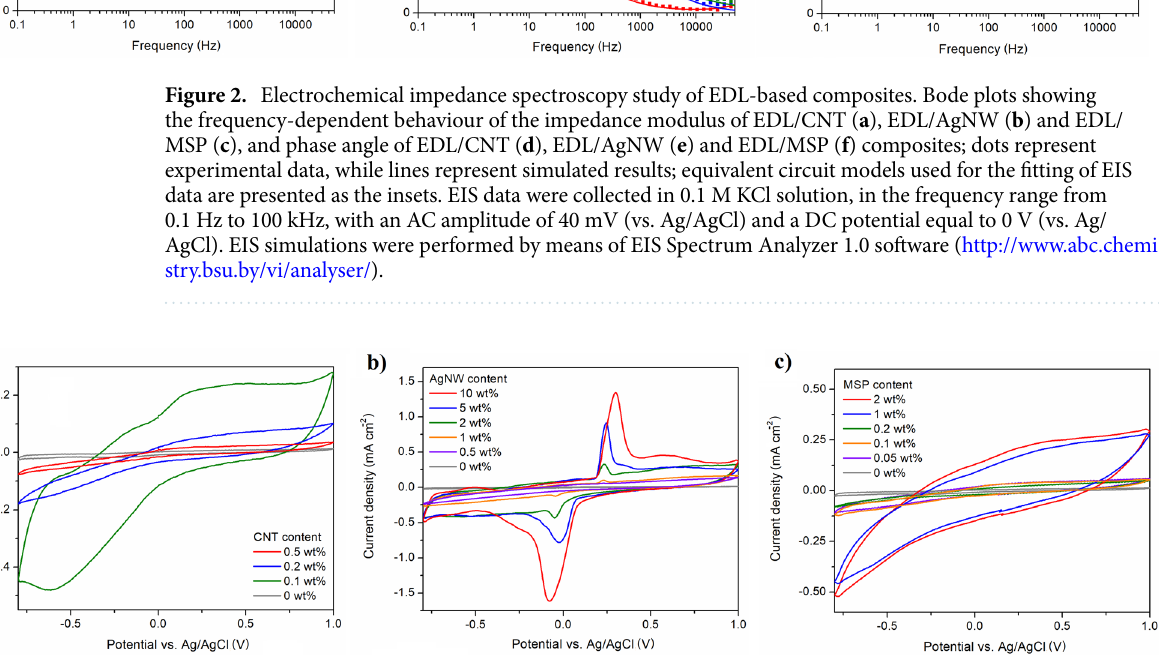
the CV curves of EDL/AgNW nanocomposites (Fig. 3b) were characterized by a distinctive reduction–oxidation system at the potentials of − 0.05 V (reduction of silver) and 0.25 V (oxidation of silver), appearing for composites with AgNW contents above 0.5 wt%. With an increase in AgNW content, an increase in the peak current was observed, accompanied by a small increase in peak separation (from 270 mV for EDL/AgNW 1 wt% to 380 mV for EDL/AgNW 10 wt%). Conversely, an increase in the area under the CV curve with no defined indication of reduction/oxidation peaks was observed for EDL/MSP (Fig. 3c), starting from an MSP content of 1 wt%. By integrating CV curves in the time domain, the charge storage capacities (CSC) of EDL composites were calculated and compared with capacitances and resistances determined from the equivalent circuit modelling of the EIS data (Fig. 4a–c). One of the most common models is a Randles circuit, which is frequently used to simulate electrode–electrolyte interface impedance of coated electrodes 17 . For the purpose of modelling, a modi- fied Randles circuit was used, including a solution resistance (R 1 ), charge transfer resistance (R 2 ), constant phase element modeling the non-faradaic processes (CPE 1 ), Warburg element representing the finite length diffusion of faradaic current (W), resistance to charge conduction in the solid electrolyte interphase layer (film resistance,